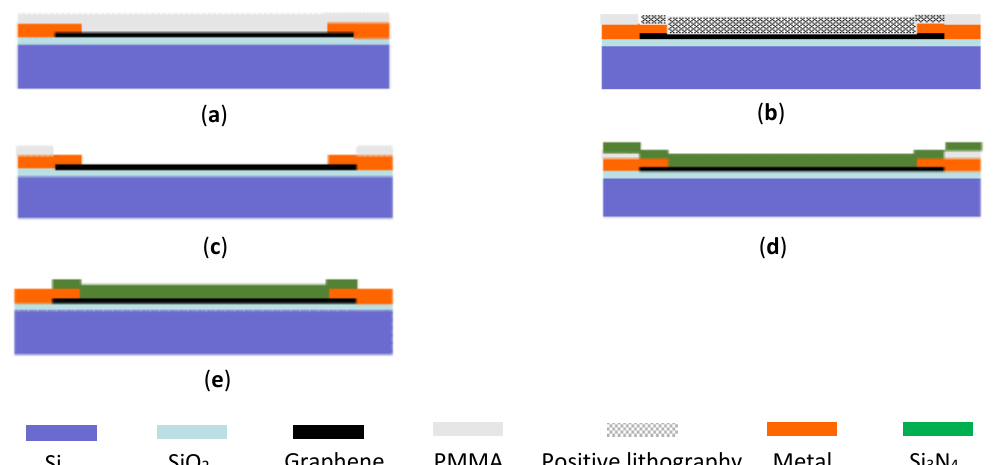
Figure 8. The preparation process of the dielectric layer. ( a ) Spin-coating positive photoresist ( b ) Electron-beam lithography ( c ) Positive photoresist development ( d ) CVD Si3N4 ( e ) Stripping.